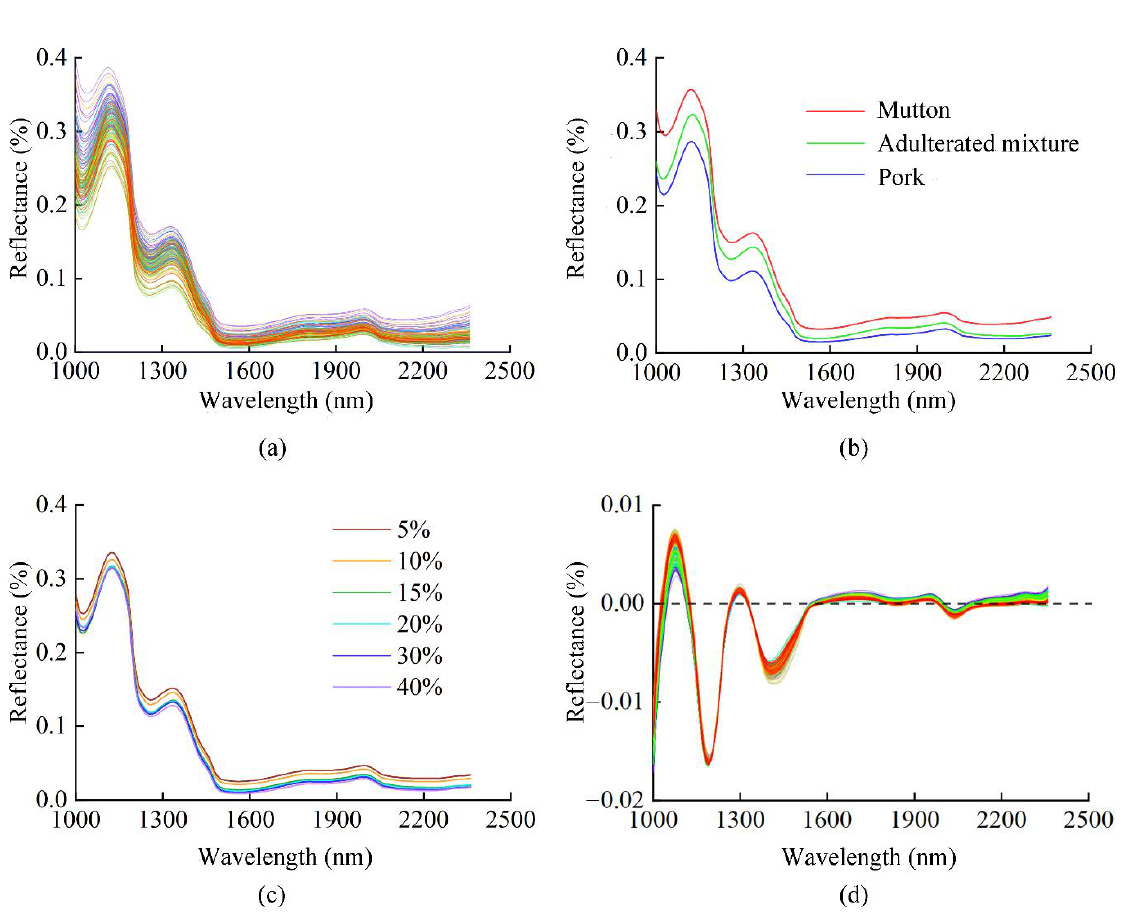
Figure 2. Spectra of samples. ( a ) Original spectra of all samples; ( b ) average spectra of different classes; ( c ) average spectra of different proportions; ( d ) spectra preprocessed with 1D + MSC.